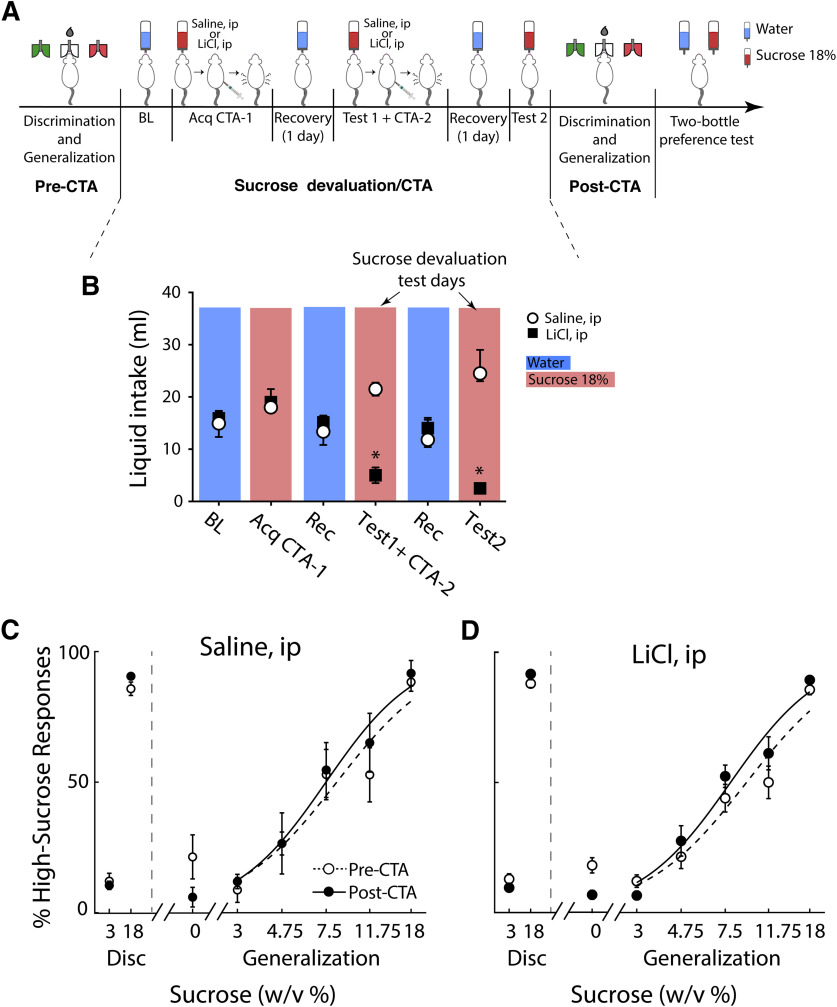
Devaluating sucrose’s hedonically positive palatability does not affect sucrose’s response to concentration (intensity). A, Timeline of the experimental design. After the animals were trained to identify sucrose concentrations, as shown in Figures 1, 2 (discrimination disk and generalization; pre-CTA), the subjects went through a sucrose devaluation procedure involving two consecutive CTAs. As a control, a baseline water consumption (blue bottle) was measured over 15 min. The next day after baseline testing for water, the animals were given 18% sucrose (red bottle) to consume, and 15 min later, they received an intraperitoneal injection of 0.2 m lithium chloride (LiCl), a visceral malaise agent [Acquisition of first CTA (Acq CTA-1)]. Then, after a recovery day, the subjects were again given 18% sucrose for 15 min to consume followed by the second injection of 0.2 m LiCl or saline (test 1 + CTA-2). After a recovery day, test 2 was performed by measuring the intake of 18% sucrose. After the CTA protocol, sucrose intensity task was re-evaluated (pre-CTA vs post-CTA, see C, D). Finally, a sucrose preference test was conducted using a two-bottle test to confirm that it remained aversive at the end of the experiments (for results, see Fig. 4). B, A histogram showing liquid intake for several of the epochs shown in dashed line expansion of A; 15 min after liquid intake, rats were injected with saline (open circle) or 0.2 m LiCl (black rectangles). Blue and red background shadows depict conditions where subjects had access to water and sucrose, respectively. The two upper arrows indicate the two test days where it can be seen that subjects developed CTA. * Significant differences between saline and LiCl groups. Data are shown as median ± iqr. C, Percentage of times the subject in the saline group classified a sucrose concentration as “high.” Performances obtained before and after CTA are represented by the open, and black filled circles, respectively. The dashed (pre-CTA) and solid (post-CTA) lines are the fitted sigmoid, respectively. The x-axis is scaled logarithmically. Data are presented as mean ± SEM. D, Same as in C but for rats injected with LiCl. These results suggest that sucrose’s intensity attribute is the main orosensory feature used by rats to solve the task. Extended Data Figure 3-1 shows values for the other behavioral measurements, and Extended Data Figure 3-2 shows the performance of each individual rat.